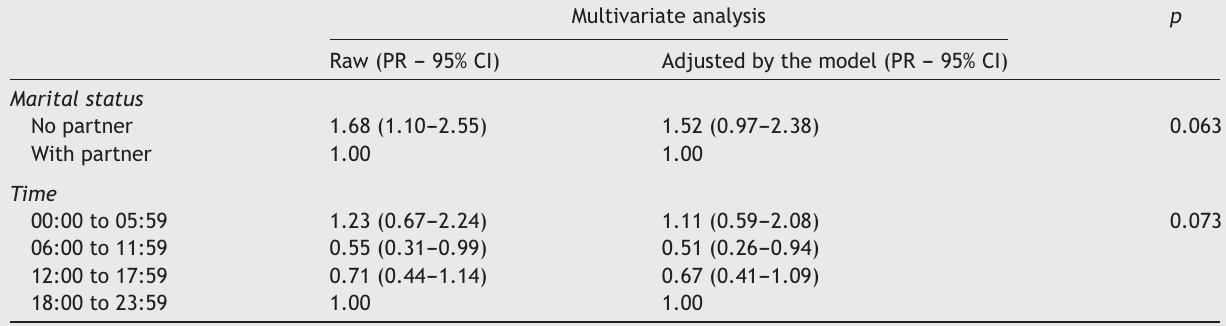
Poisson multivariate regression for analysis of percentage of facial injury based on independent variables included in the